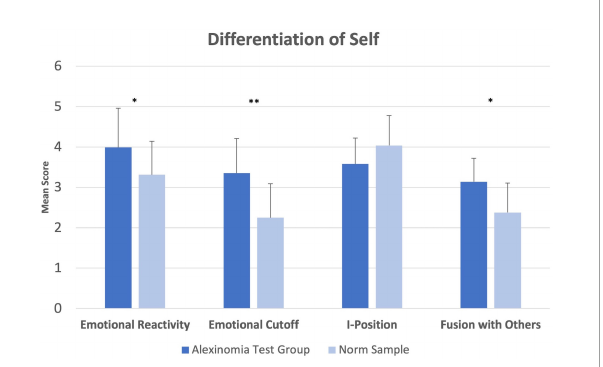
FIGURE2 Social Interaction Anxiety Scale (SIAS). Individual scores and group mean (dotted line) in the SIAS. The solid line indicate the SIAS cutoff value for social anxiety.